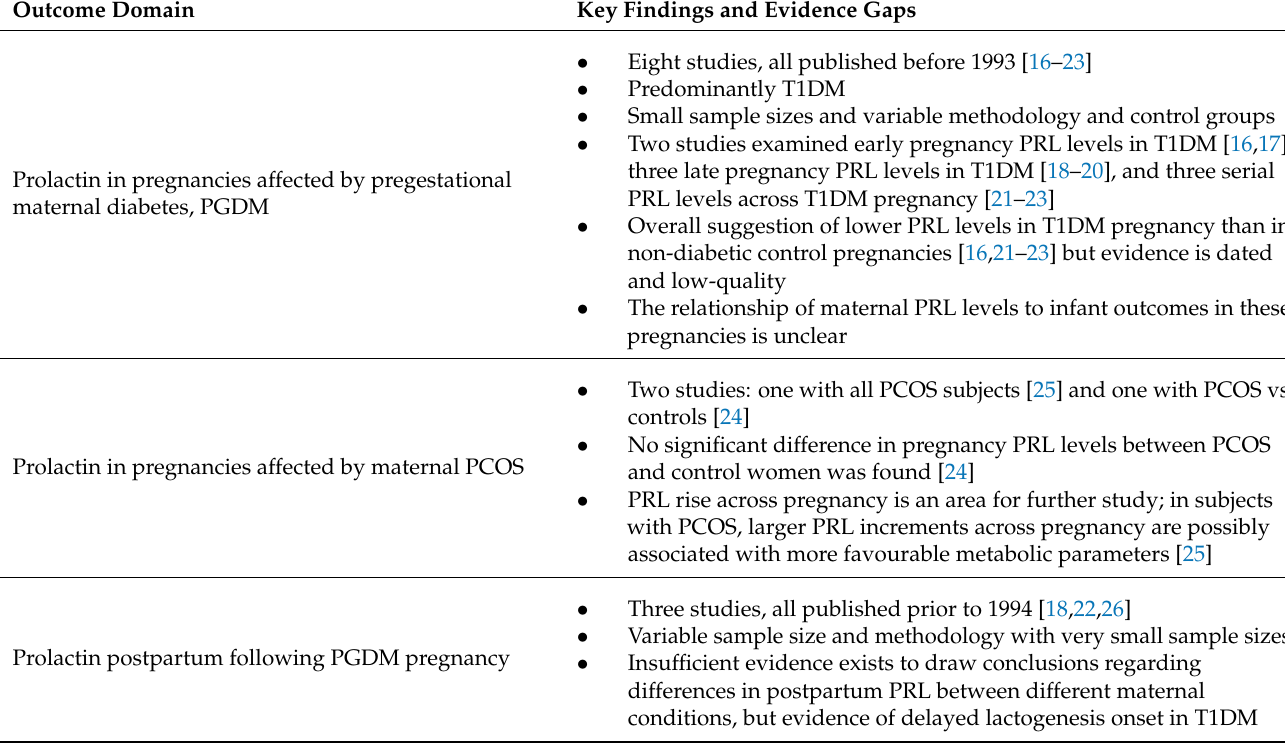
Table 1. Summary of key review